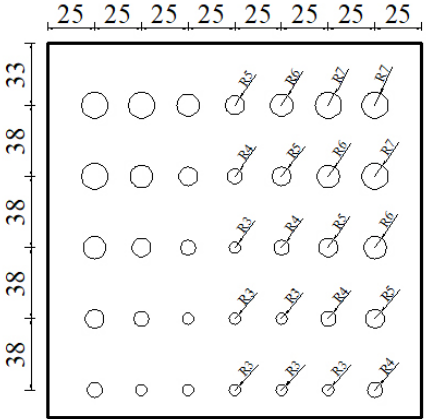
Figure 3. Schematic diagram of the flow adjustment board (all the dimensions are in centimeters).